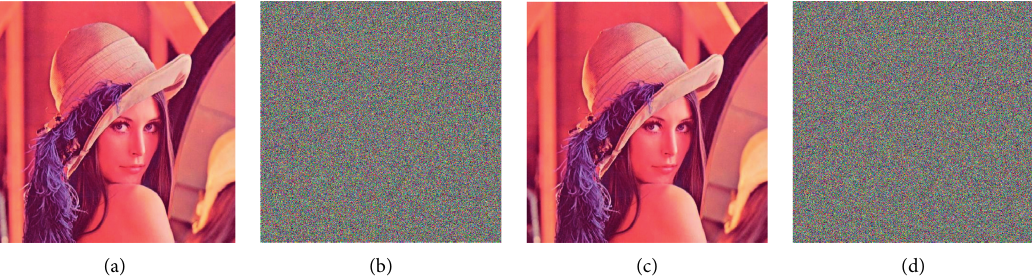
,y , z + δ , y , z 􏼈 􏼉 and 􏽥 K � x 􏼈 􏼉 , where δ � 10 − 16 . (a) The original image; (b) 0 0 0 0 0 0